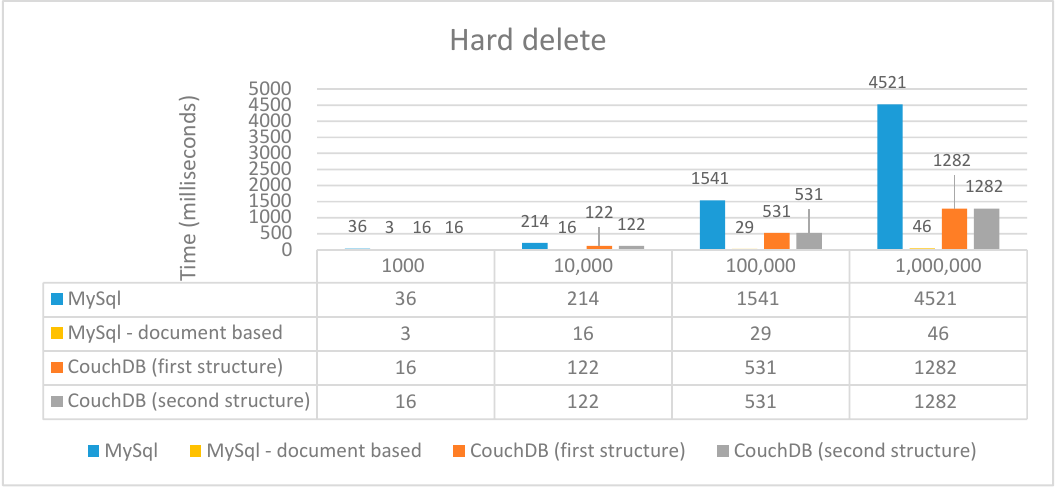
Figure 13. Performance time (ms) for hard delete.